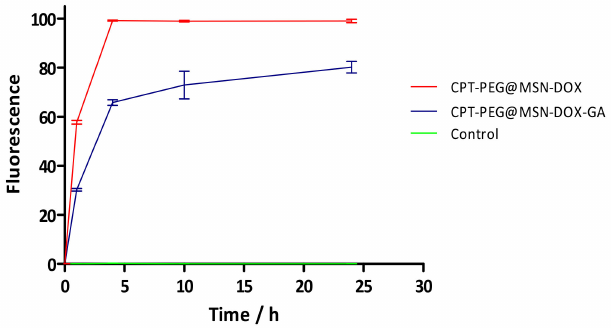
Figure 5. Kinetics of CPT-PEG@MSN-DOX and CPT-PEG@MSN-DOX-GA by Flow Cytometry analysis of HepG2 cells at 1, 4, 10, and 24 h at 100 µ g · mL − 1 . Data represented as mean ± SD ( n =